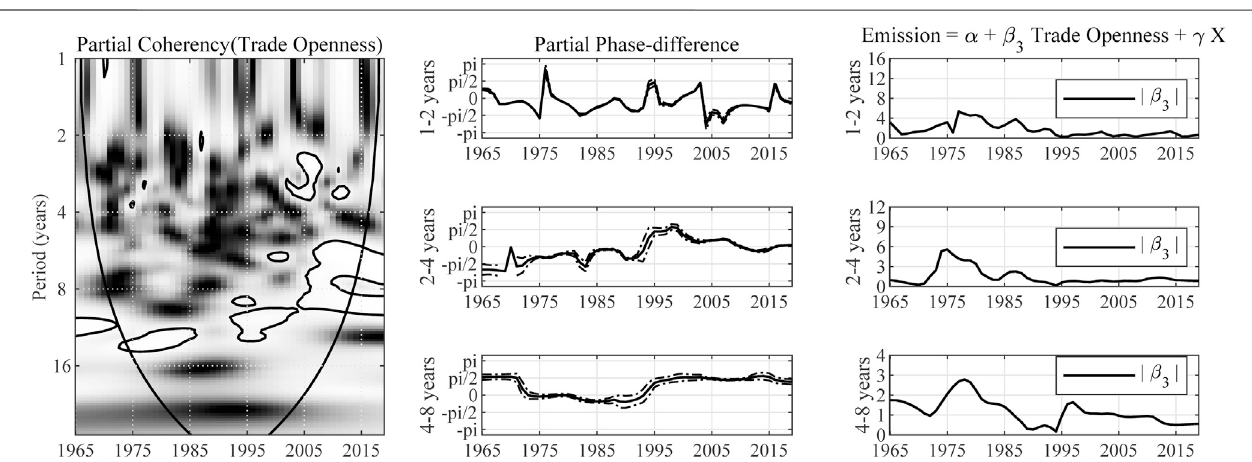
FIGURE 5 | Impact of trade openness on carbon emission in China. Note: The expression “ Partial Coherency (Trade Openness) ” denotes the partial coherency between trade openness and carbon emission, controlled for the in fl uence from energy structure and economic growth. The areas below the symmetric black convex curve that appears in the fi gure of coherency are called the “ Cone of In fl uence (COI), ” in which the edge effects are profound. Inside the COI, the results tend to be unreliable. The contours in the coherency diagrams indicate 5% signi fi cance level, bootstrapped for 10,000 replications. And, the brighter colors correspond to higher signi fi cance level, and darker colors correspond to lower signi fi cance level. The dotted lines accompanying the partial phase-difference indicate the 95% con fi dence intervals.